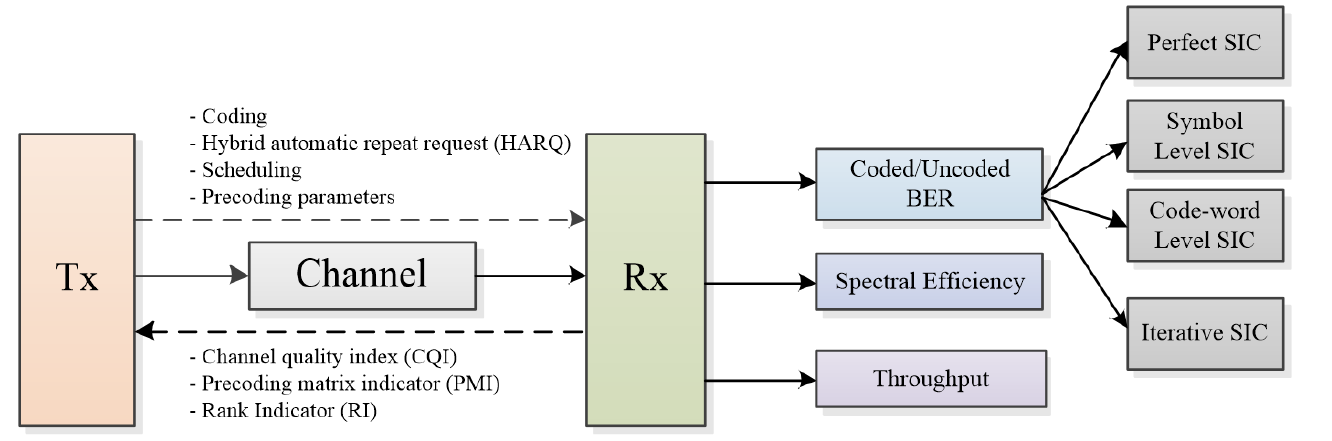
Figure 1. NOMA link-level simulator overall